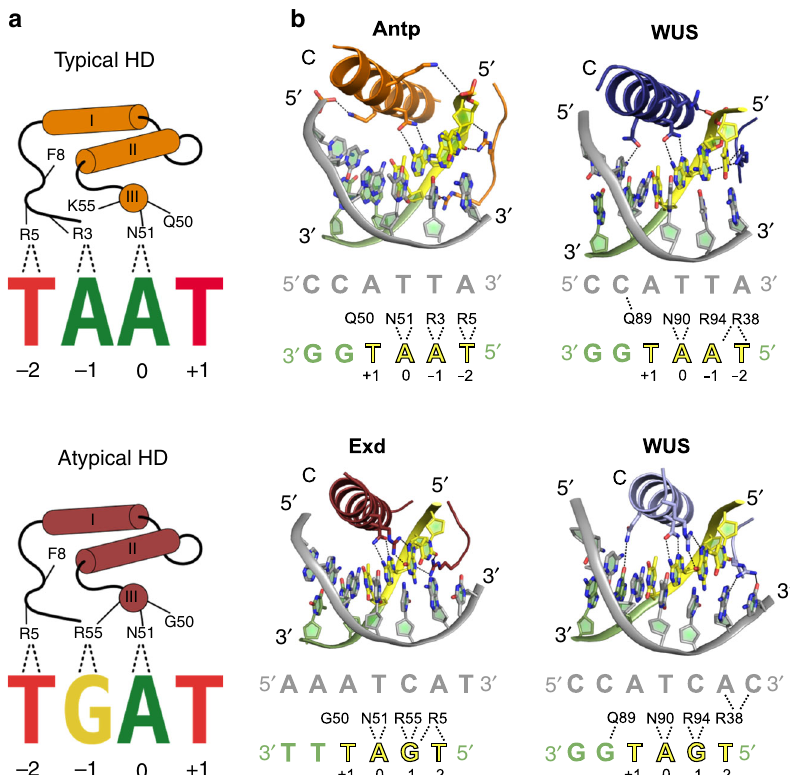
Fig. 3 Comparison of sequence speci fi city with typical and atypical HDs. a Schematic representation of DNA sequence speci fi city for typical and atypical HDs. The DNA base-recognition details are depicted for a typical HD in orange (top) and an atypical HD in red (bottom). Note the speci fi c read-out of the adenine at position 0 by N51, characteristic for HD proteins. The numbering of residues is according to the Antp-HD 34 b DNA base-recognition details of WUS compared to other HDs. Top, showing hydrogen bond interactions of Antp (orange, PDB 4XID 34 ) and WUS with the same typical core DNA recognition motif (yellow). Bottom, showing hydrogen bond interactions of Exd (red, PDB 2R5Y 30 ) and WUS with the same atypical core DNA recognition motif. Diagrams below each cartoon representation summarize DNA-base contacts made by each